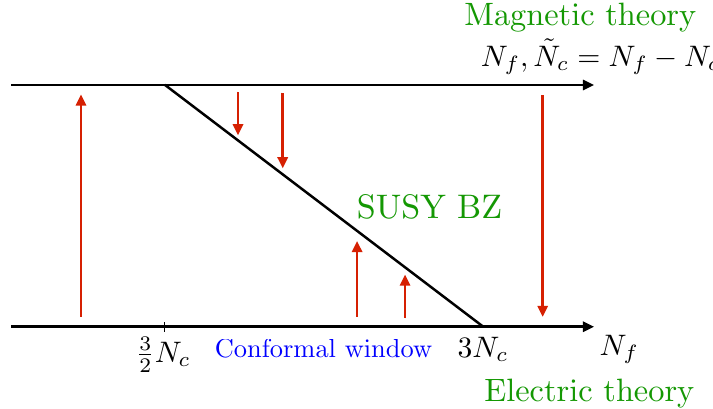
Figure 5 . Conformal window for the = 1 SUSY case. In this case the BZ-like (cid:12)xed point N disappears by merging with another free theory. Compare with (cid:12)gure 4 in the non-SUSY